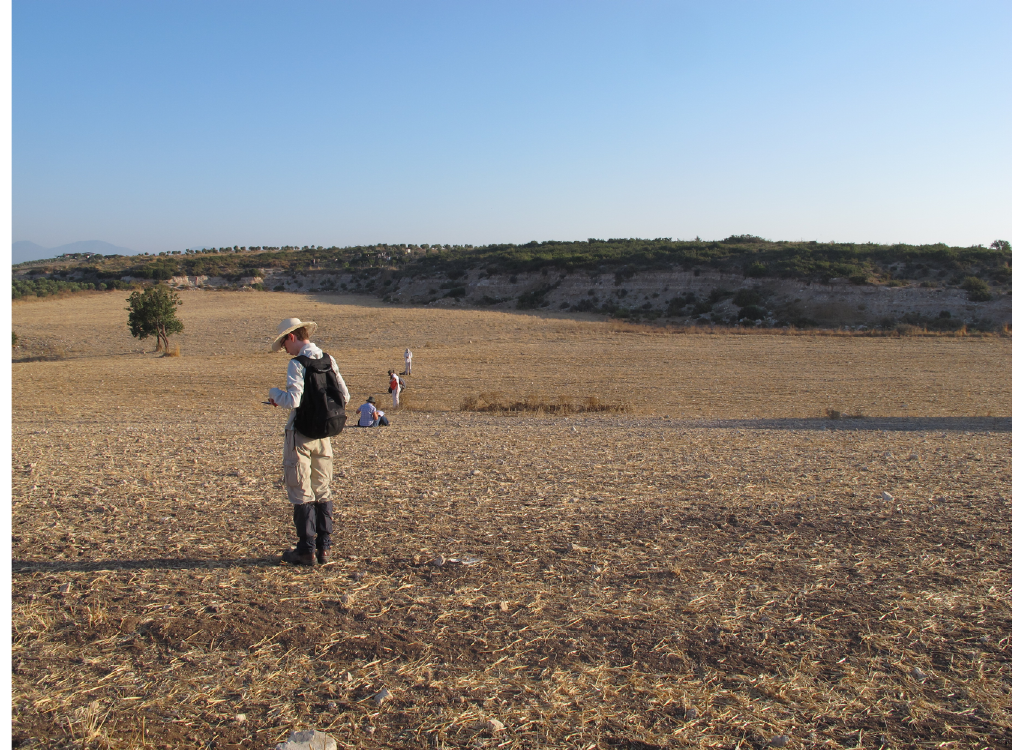
Figure 1. Team entering data after walking a tract in the landscape around Panormos (Photograph by: Toby C.